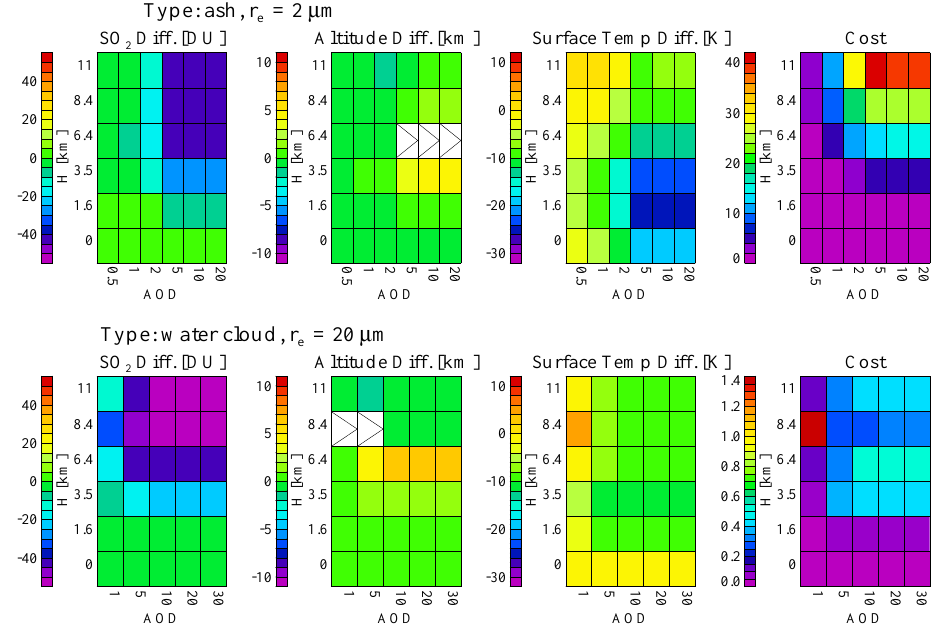
Fig. 6. Difference between the retrieved value and known value for SO 2 column amount (first column), altitude (second column), surface temperature (third column). The fourth column shows the value of the cost function. The synthetic IASI data used in the retrievals were based on the reference clear atmosphere containing a SO 2 column amount of 50DU, normally distributed about 400mb. The surface temperature was taken as 270K. The results are shown for top row the presence of an ash layer, the bottom row the presence of a cloud layer. The optical depth and altitude of the ash or cloud layer are a function of the x and y axes